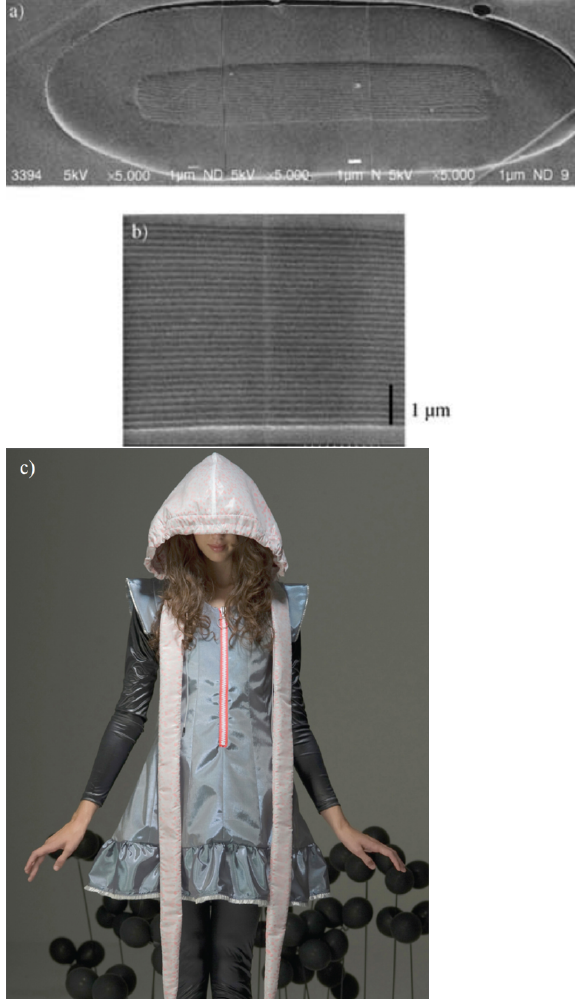
Fig. 17. (A,B) Morphotex cross-sections [83] Image Teijin Fibers Ltd., (C) Morphotex dress (permission from Donna Sgro who is a staff member at the author’s university